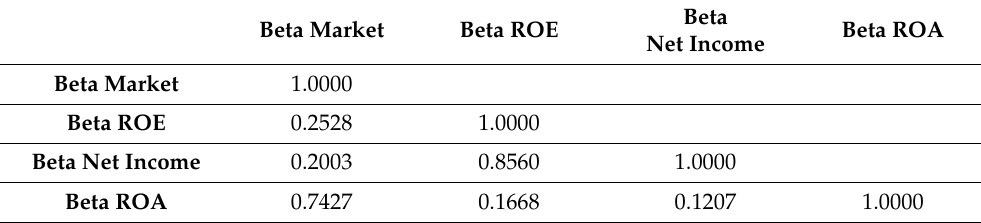
Table 3. Correlation